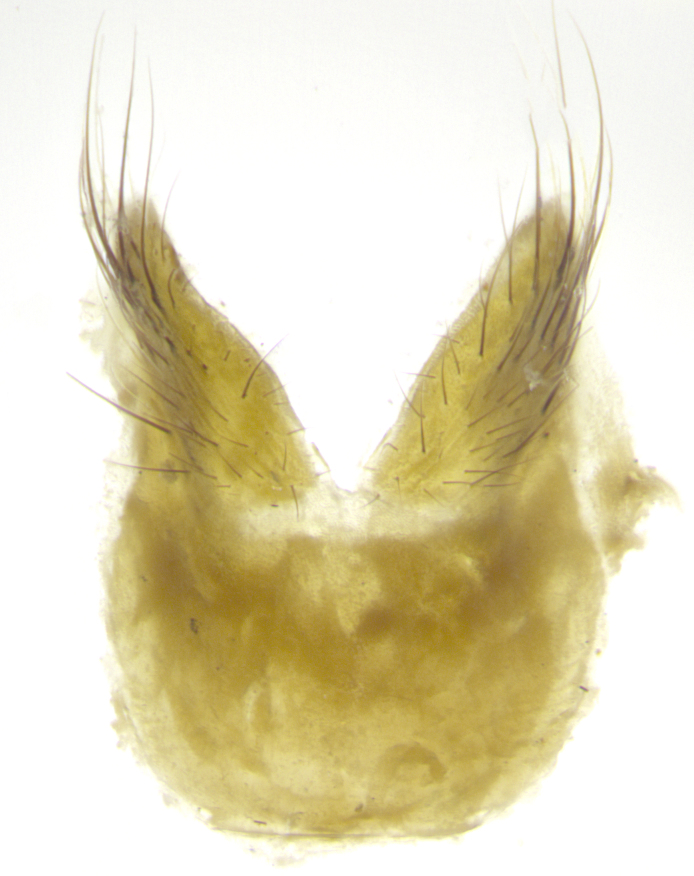
sternite 5, ventral view.